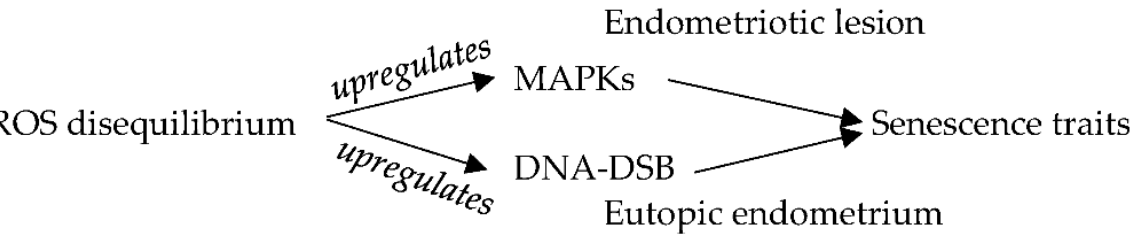
Figure 6. Summary Hypothesis Schema.